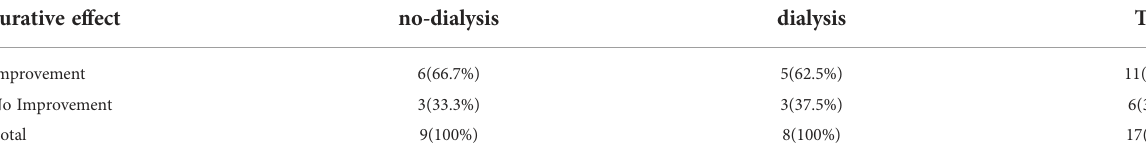
TABLE 5 Improvement of renal function in dialysis and no dialysis patients with IgD MM and acute RF.